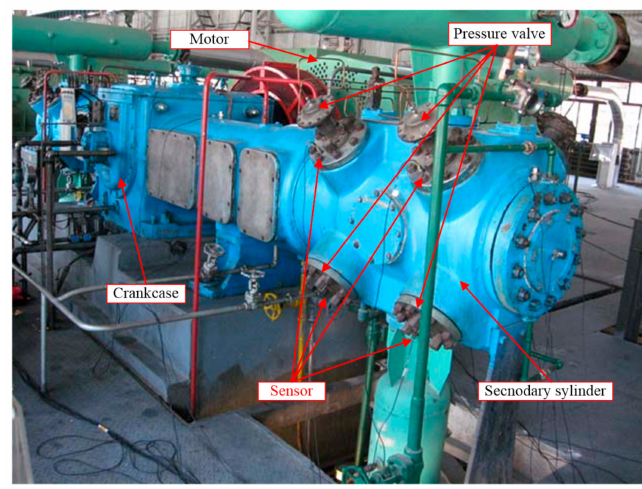
Figure 10. Actual positions of the valve and sensors.